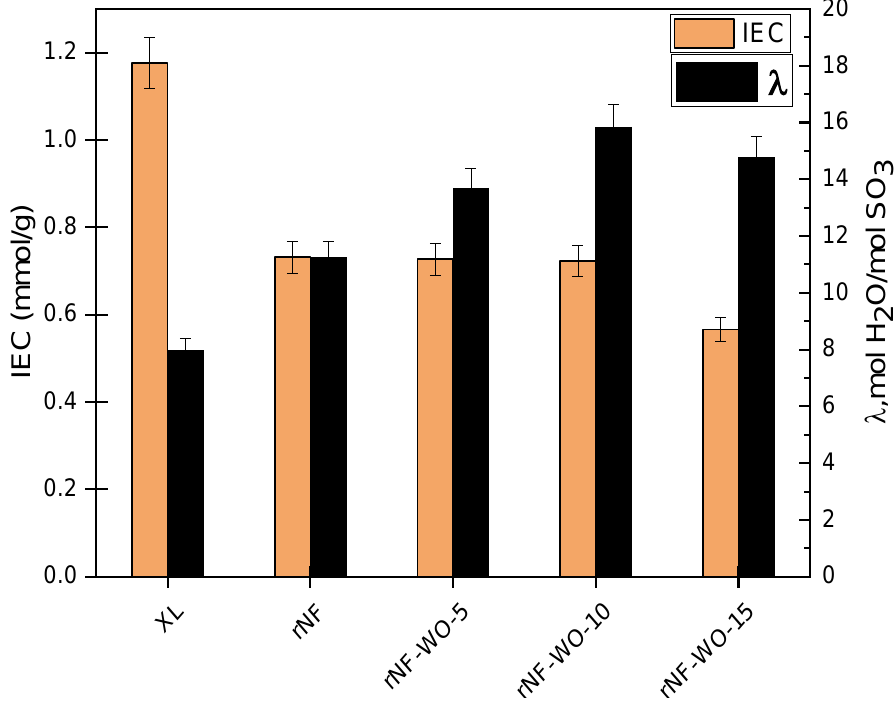
Figure 10. Ion exchange capacity and hydration degree analysis of the commercial, rNF, and rNF – WO 3 hybrid membranes.